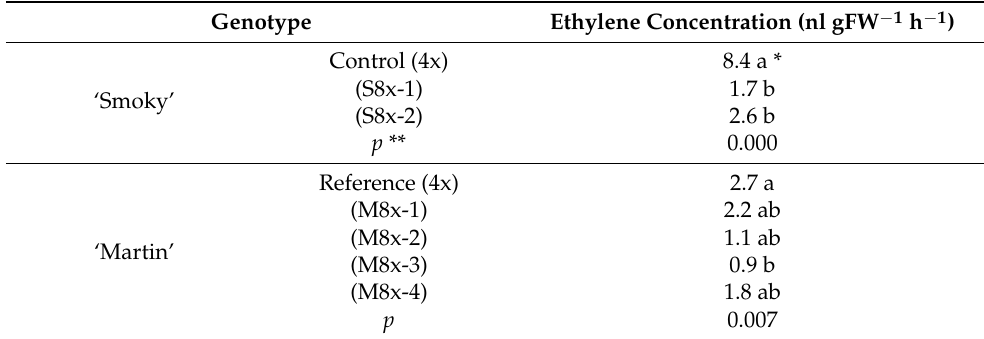
Table 4. Release of ethylene during in vitro propagation of Amelanchier alnifolia tetraploids cvs. ‘Smoky’ and ‘Martin’ (4x) and octoploid clones (8x).